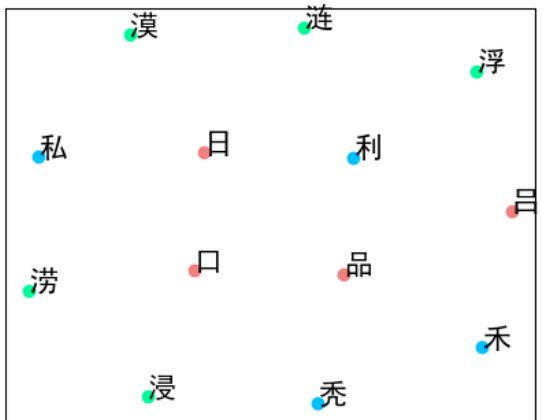
Figure 13. T-SNE visualization of embeddings learned from SAE architecture (different colors represent different classes).